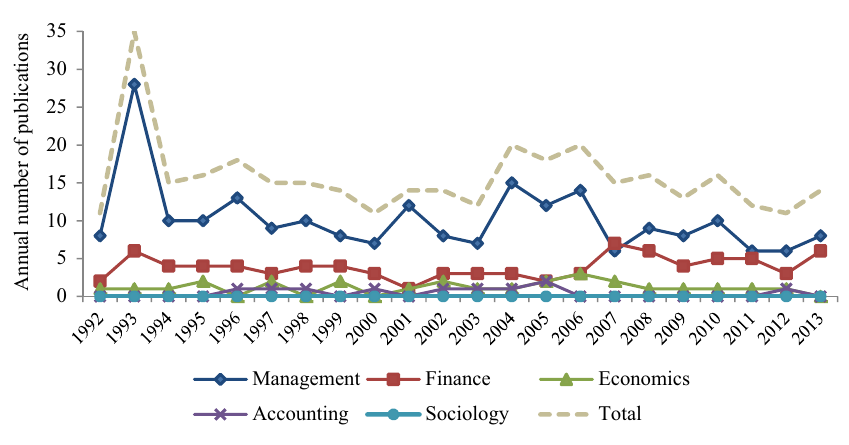
Fig. 1 Research articles on corporate distress and turnaround by research field